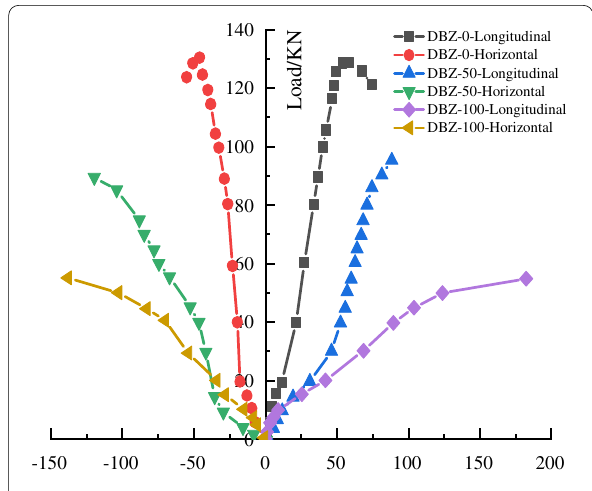
Fig.7 Load–displacement curve of DBZ under different